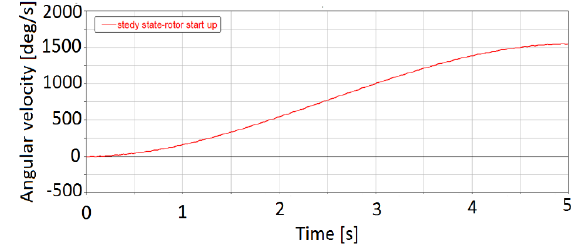
Fig. 12. Rotor speed course during start-up